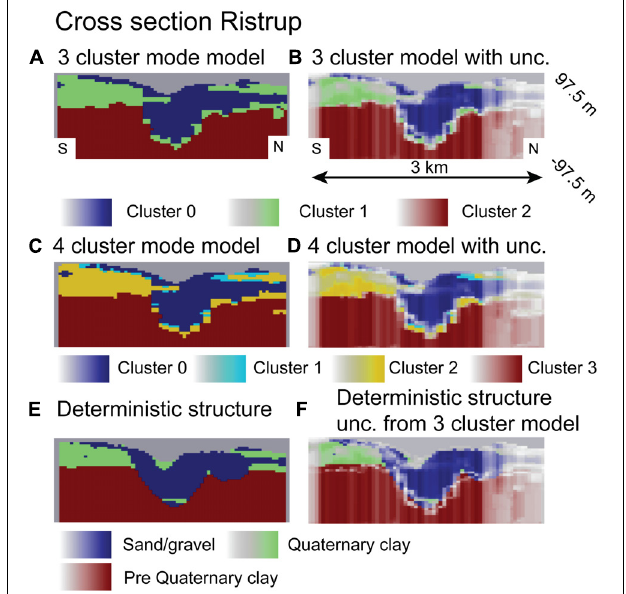
FIGURE 7 | Cross-section through the Ristrup model (see Figure 1 for location). (A) 3 cluster TI, (B) 3 cluster TI blanked with uncertainty, (C) 4 cluster TI, (D) 4 cluster TI blanked with uncertainty, (E) Deterministic structure, (F) Deterministic structure blanked with uncertainty from 3 cluster